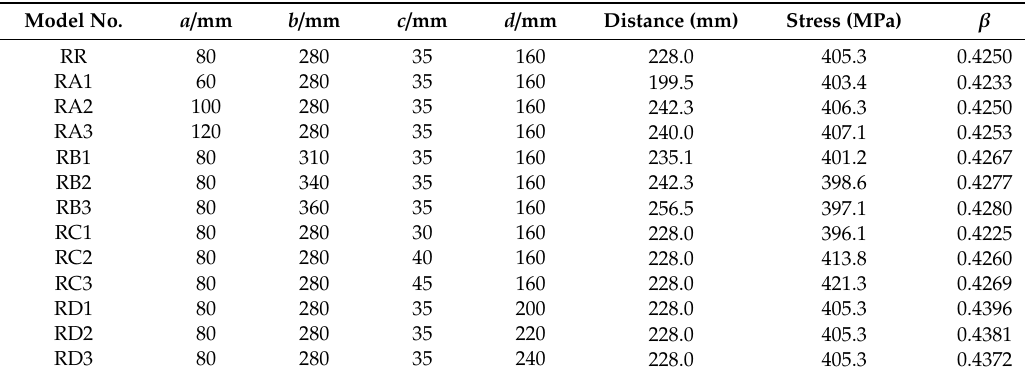
Table 1. Finite element (FE) models dimensions and measured